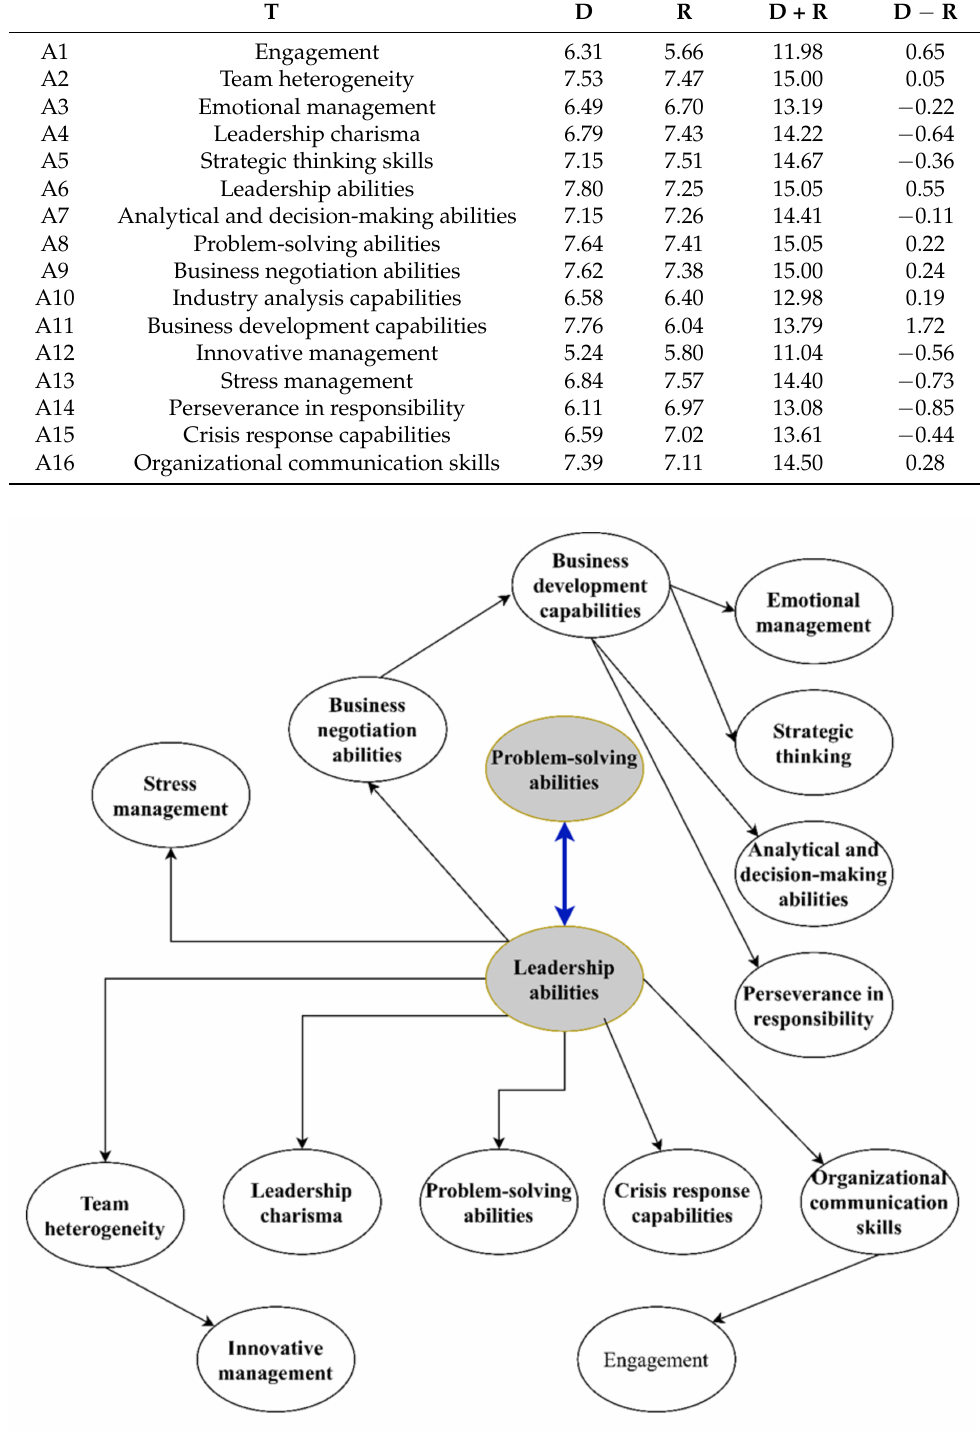
Figure 10. Network of